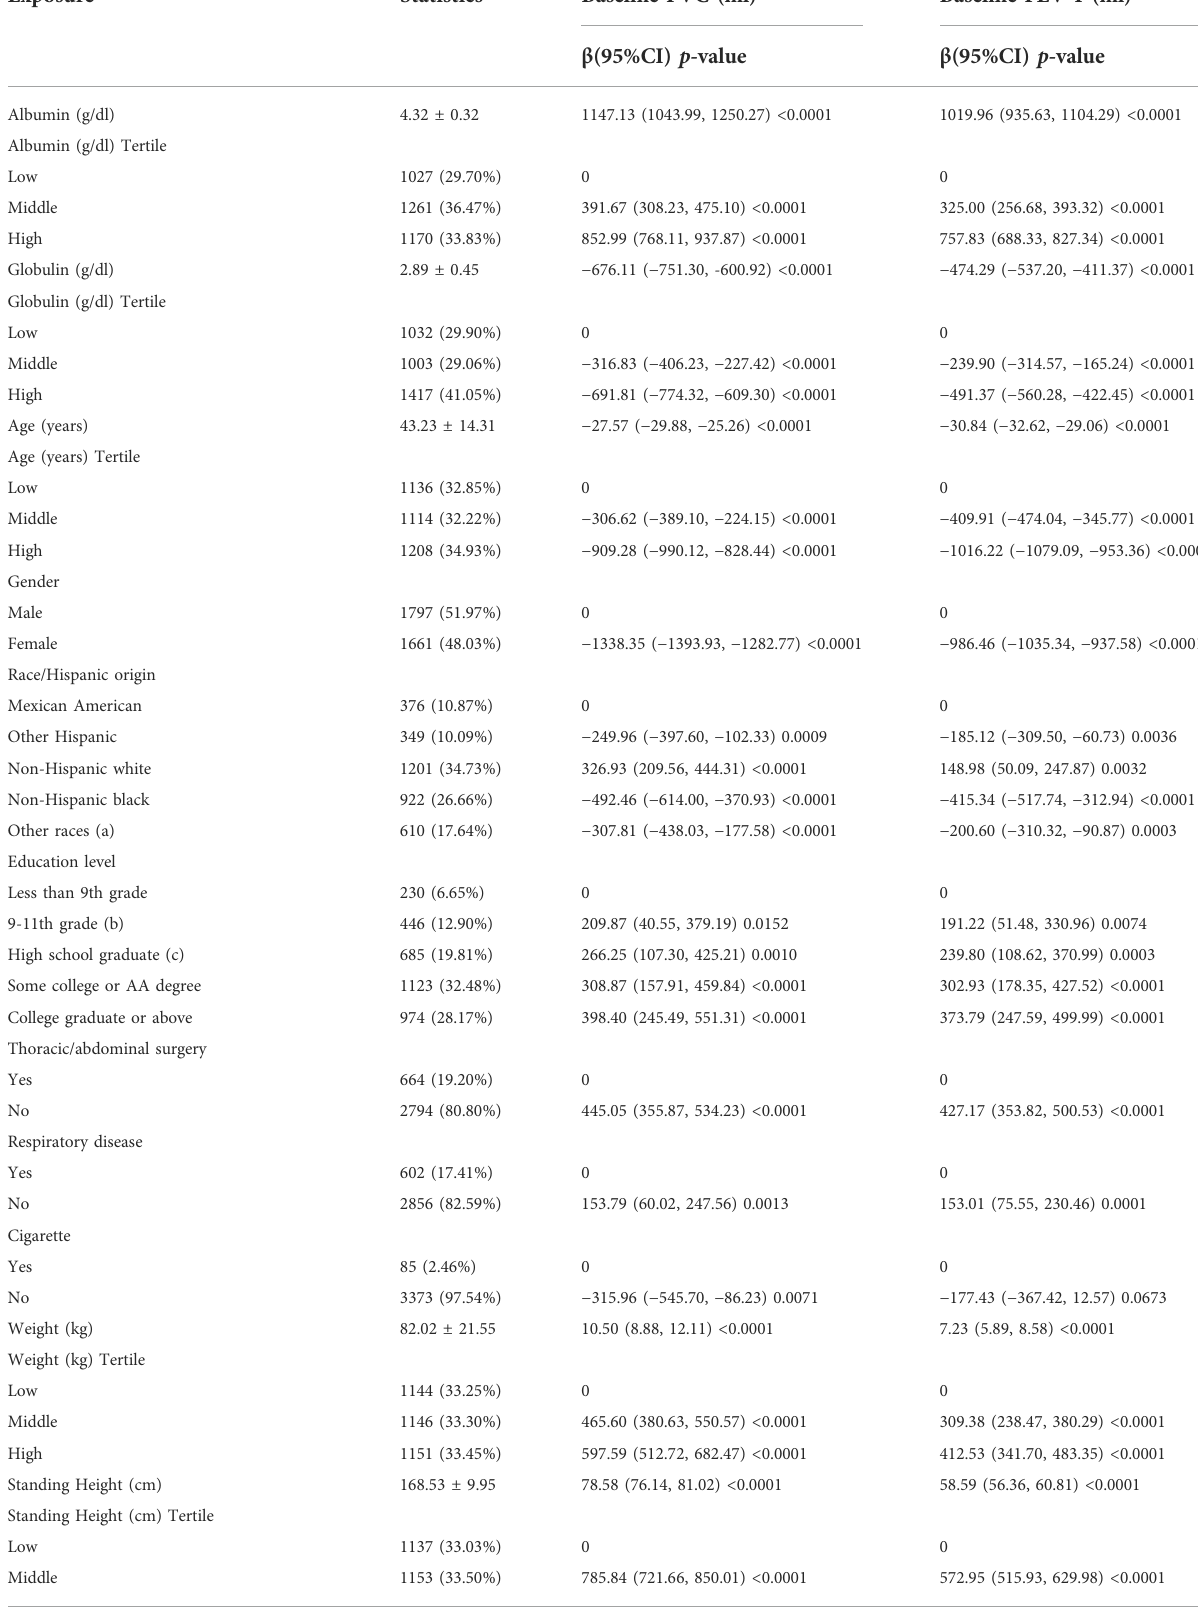
TABLE 2 Crude univariate analysis for Baseline FVC and Baseline FEV